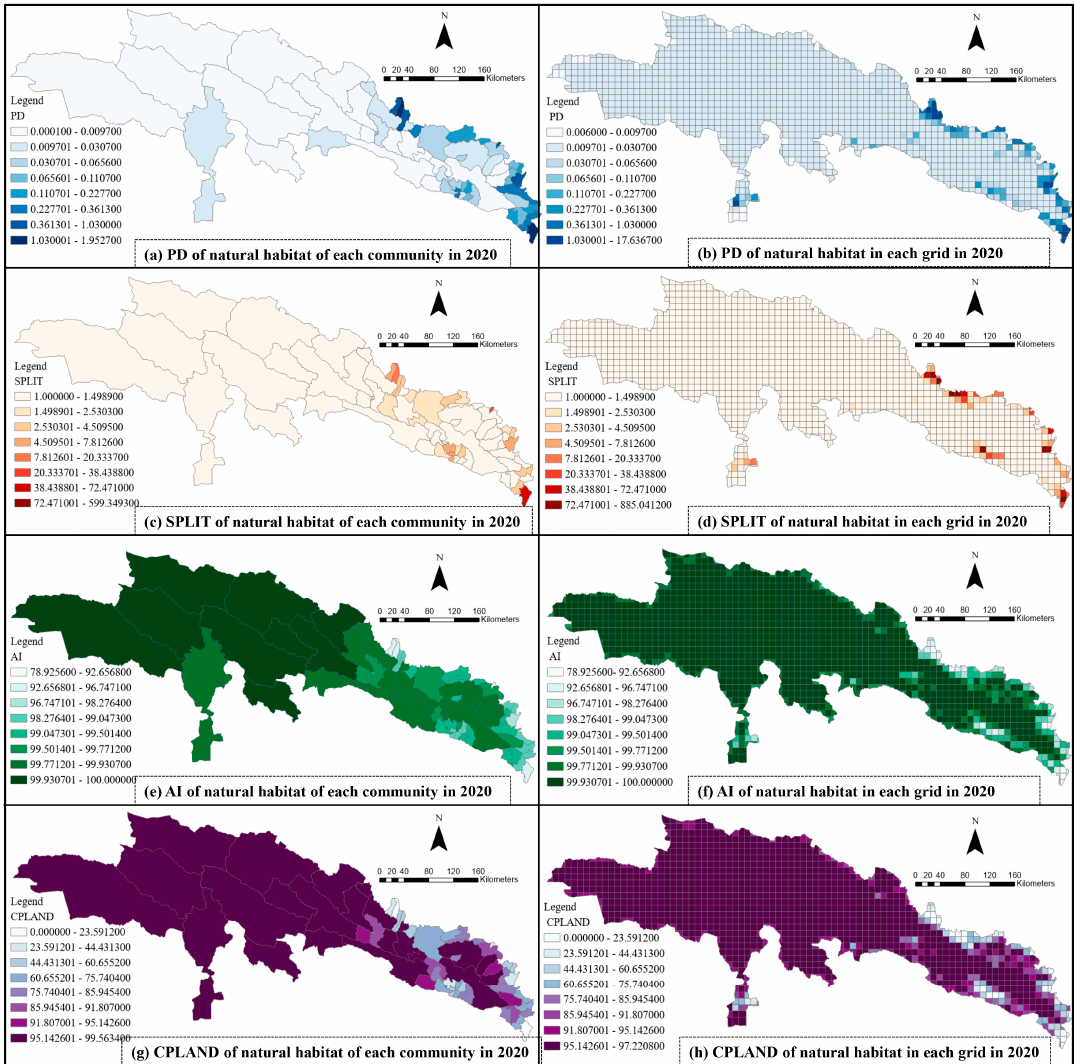
Figure 7. The spatial distributions of agricultural development in each community: ( a ) the PD of the natural habitat of each community and ( b ) in each grid in 2020; ( c ) the SPLIT of the natural habitat of each community and ( d ) in each grid in 2020; ( e ) the AI of the natural habitat of each community and ( f ) in each grid in 2020; ( g ) the CPLAND of the natural habitat of each community and ( h ) in each grid in 2020.